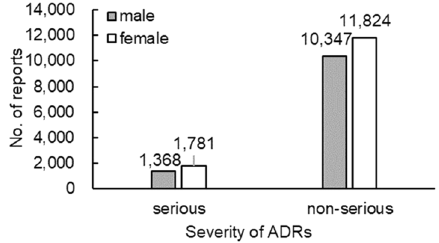
Figure 3. Number of serious and non-serious reports by sex.